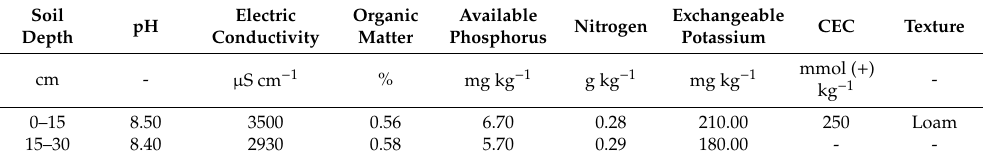
Table 5. The pre-experiment soil properties of the experimental